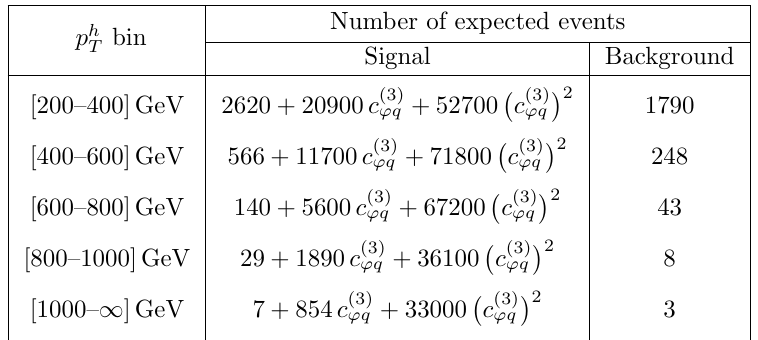
1 . The signal (cid:0)